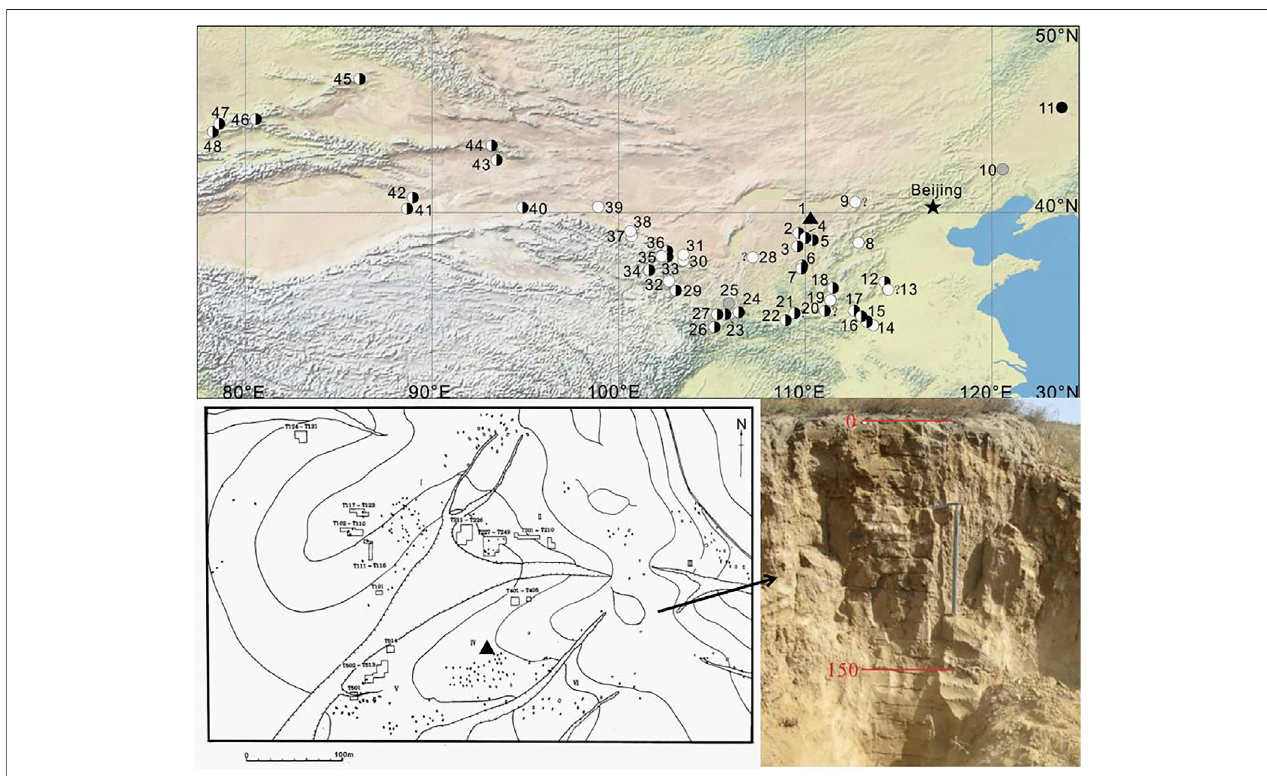
FIGURE1| LocationoftheZhukaigousiteandothersitesmentionedinthetext.Whiteandblackcirclesindicatesiteswiththeremainsofdomesticsheep/goatand cattle, respectively. Grey circles indicate sites without theremains ofdomestic sheep/goat and cattle. “ ? ” indicates asite where itisuncertain whether the sheep/goat or cattleweredomesticated.Thesitesnamesrepresentedbythenumbersareshownin Table1 .TheZhukaigousectionanditslocationintheZhukaigousite.Thelocation map of Zhukaigou site was cited from the Institute of Cultural relics and Archaeology, Inner Mongolia Autonomous region, (2000).